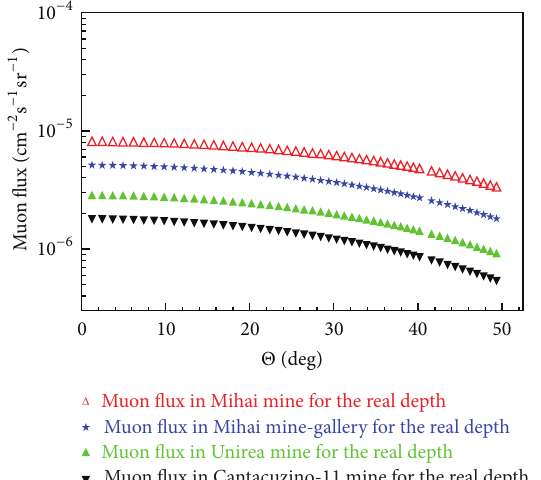
Figure 8: Simulation of the directional variation of the differential muon flux in the underground of Slanic Prahova salt mines.